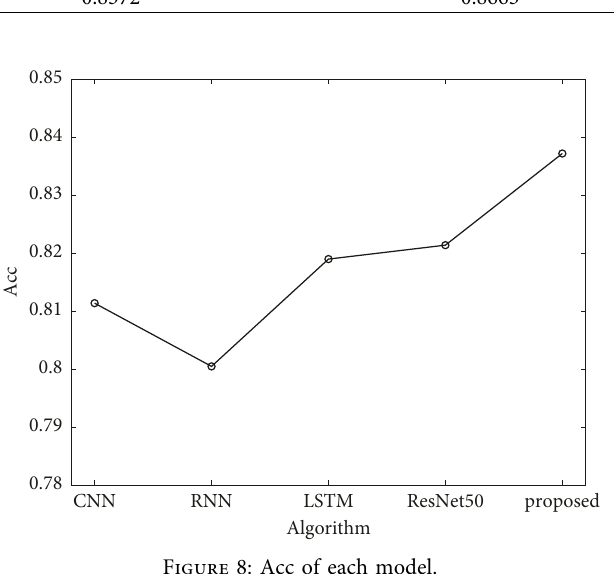
Figure 8: Acc of each model.